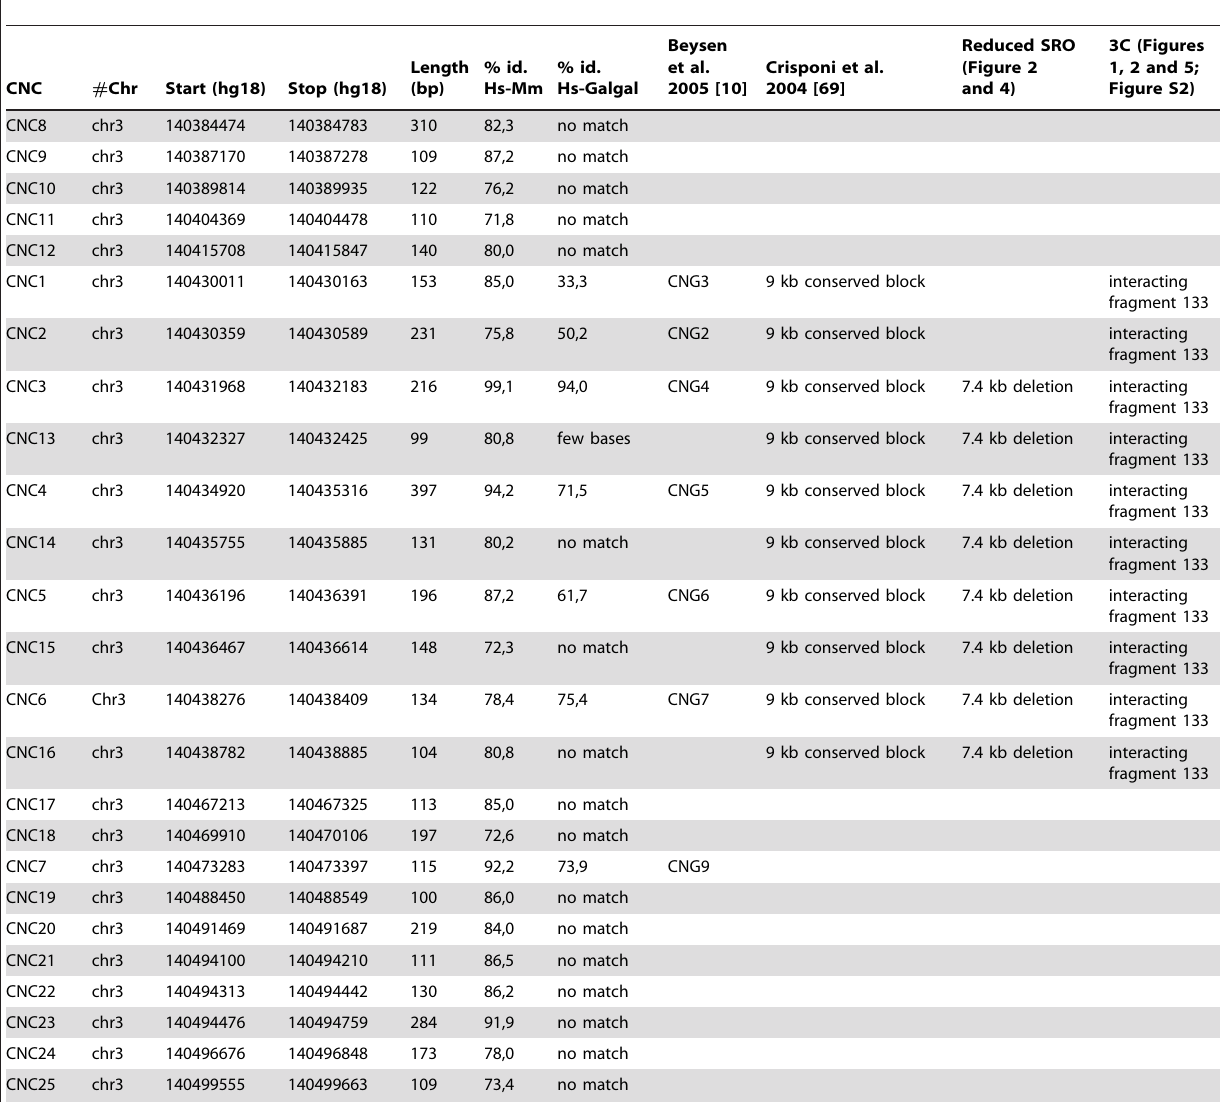
Table 1. Mapped CNCs within the initial